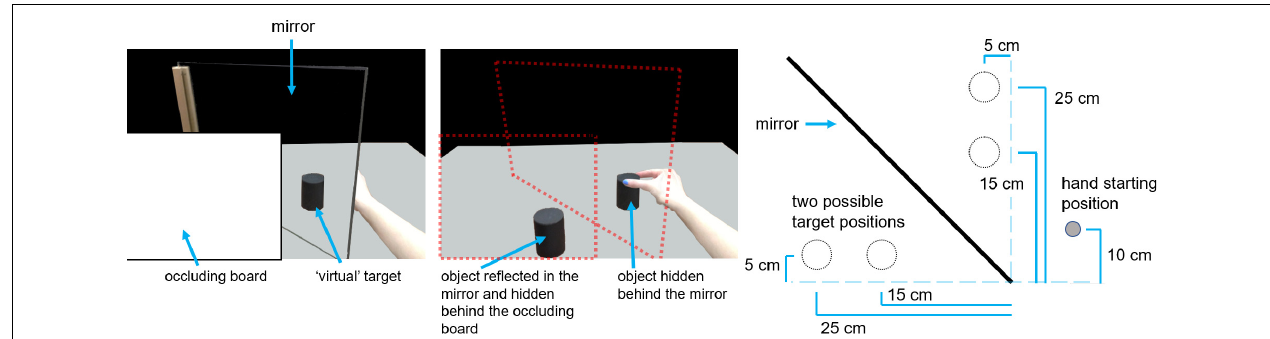
FIGURE 1 | Mirror apparatus and setup. Illustration of the participant’s view of the virtual target (leftmost panel), the occluding board and mirror removed to reveal the object reflected in the mirror, and the identically sized object hidden behind the mirror and positioned to as to match the apparent position of the virtual object (middle panel), and a schematic bird’s-eye view of the setup, including the mirror, the hand’s approximate starting position, and the two possible object locations, which are indicated with circles with dotted outlines (rightmost panel).